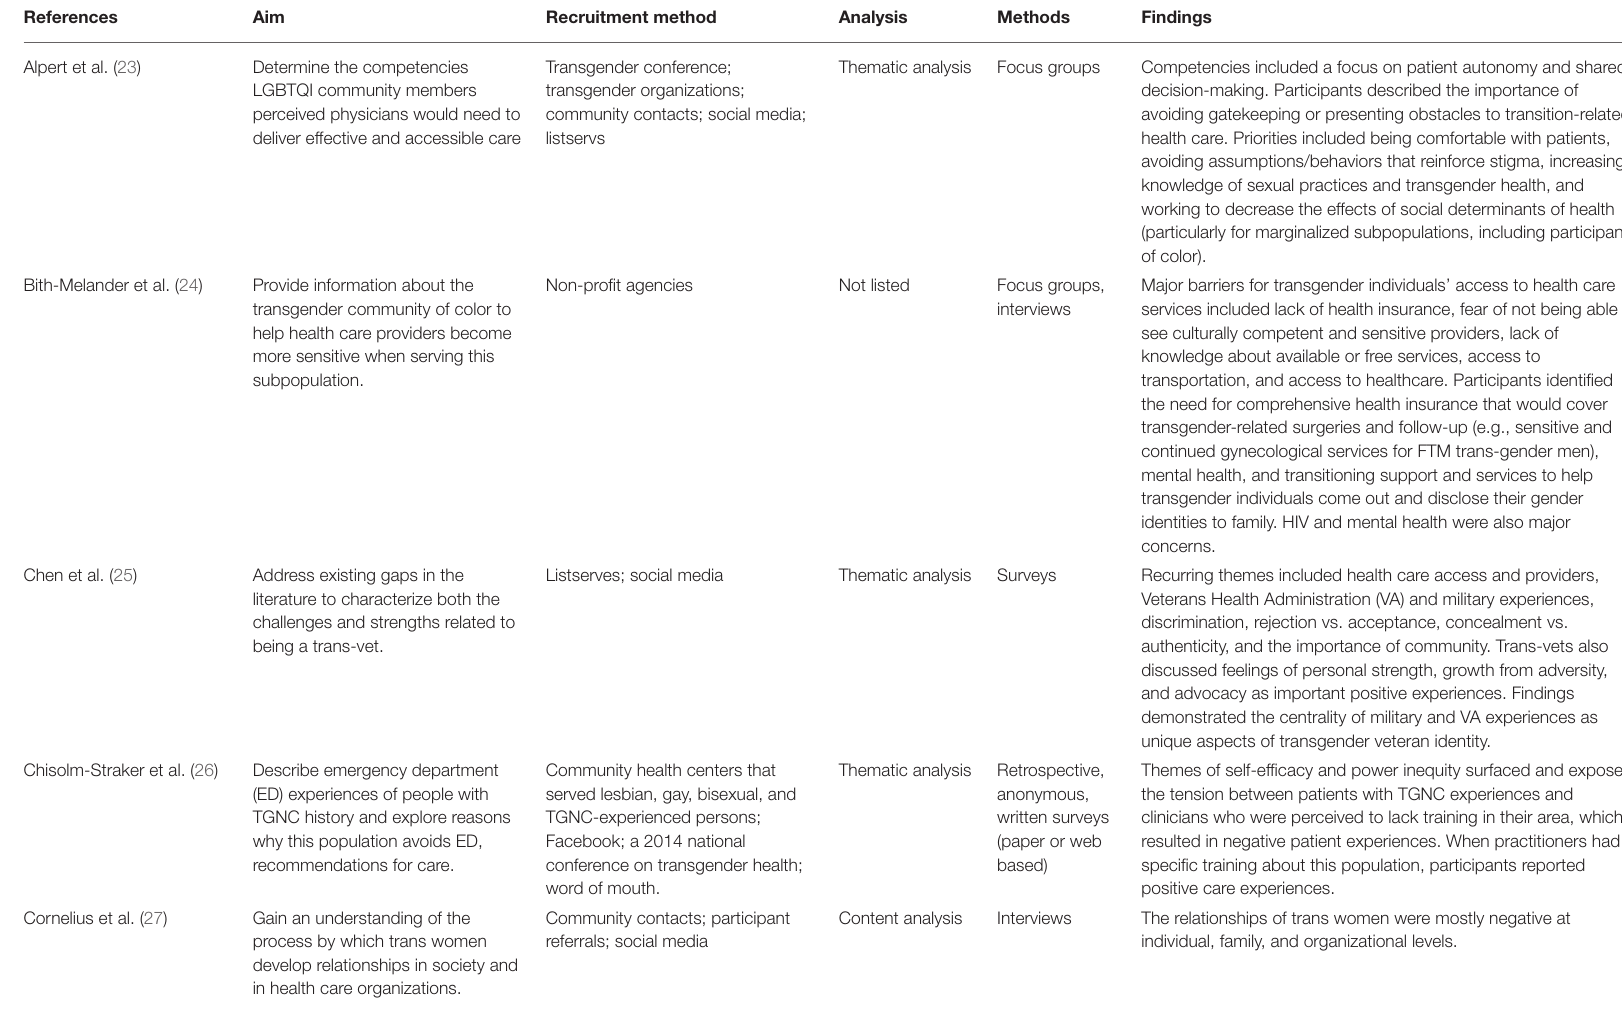
TABLE 3 | Study recruitment, methods, and